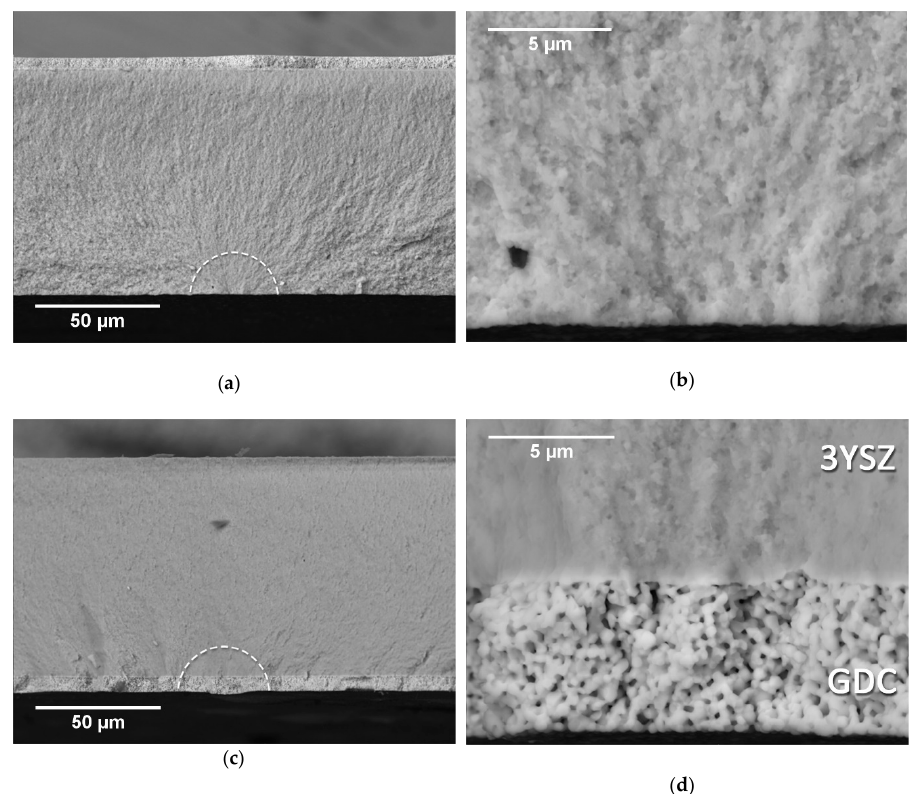
Figure 8. SEM images of the fracture surface of a SOC1 specimen tested in B3B with the electrolyte side in tension in ( a ) and ( b ), and with the GDC barrier layer in tension in ( c ) and ( d ). The fracture initiation areas are marked by the white dashed lines.